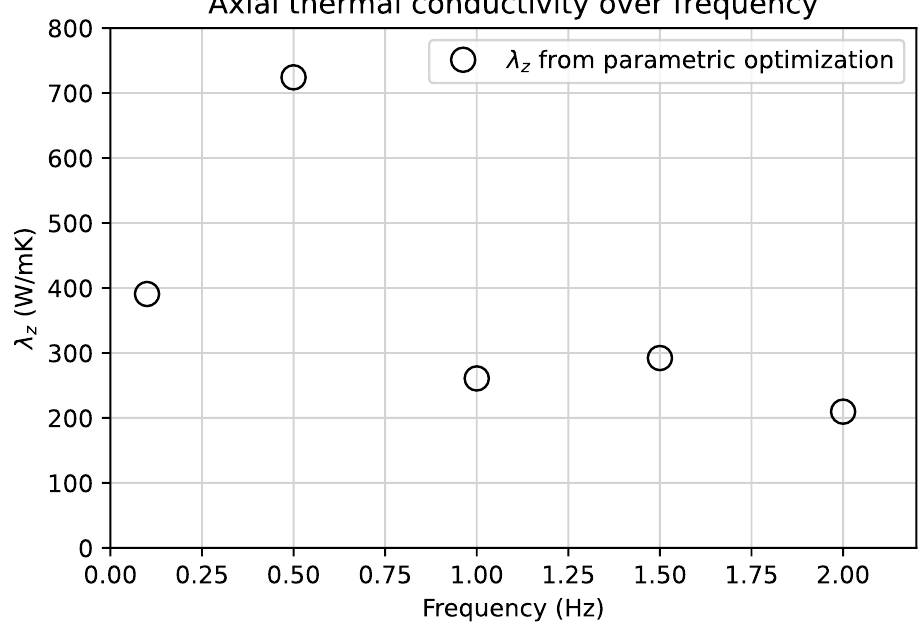
Figure 7. Resulting λ z from the optimization over the frequency f .